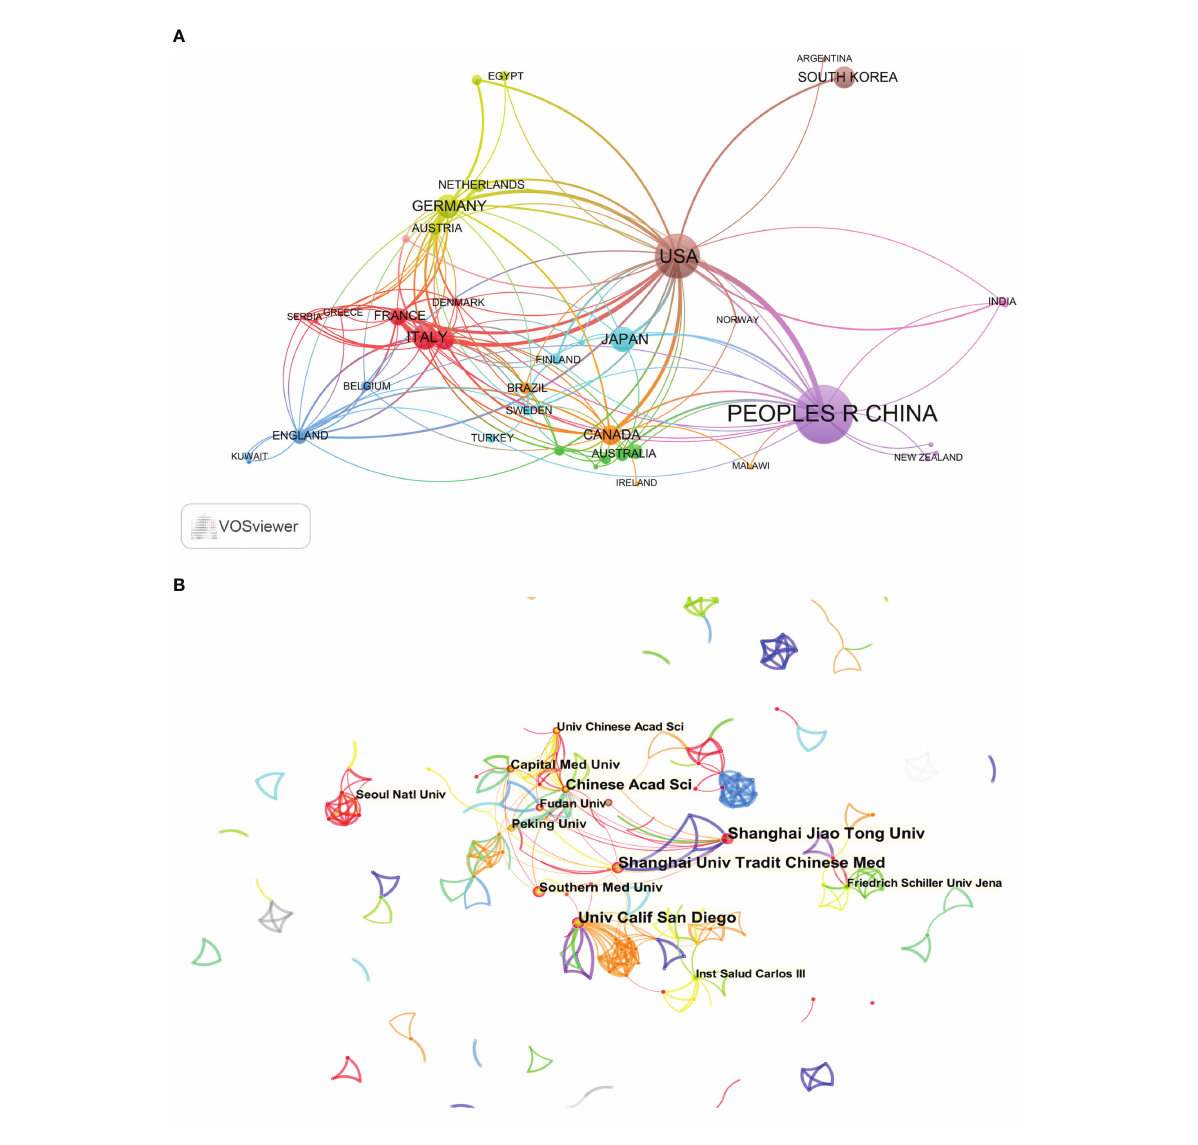
FIGURE 3 Network map of the collaboration analysis of gut microbiota and MAFLD fi eld among countries/regions and institutions in 2002-2021. (A) Cooperative relationships between 53 countries/regions on the links of gut microbiota and MAFLD from 2002 to 2021. Data was exported from the Online Analysis Platform of Literature Metrology. (B) CiteSpace network map of institutions involved in the links between gut microbiota and MAFLD research. The top 12 most productive institutions are shown. The size of the circle represents the number of articles published by each institution and the thickness of the connecting lines indicates the degree of cooperation between